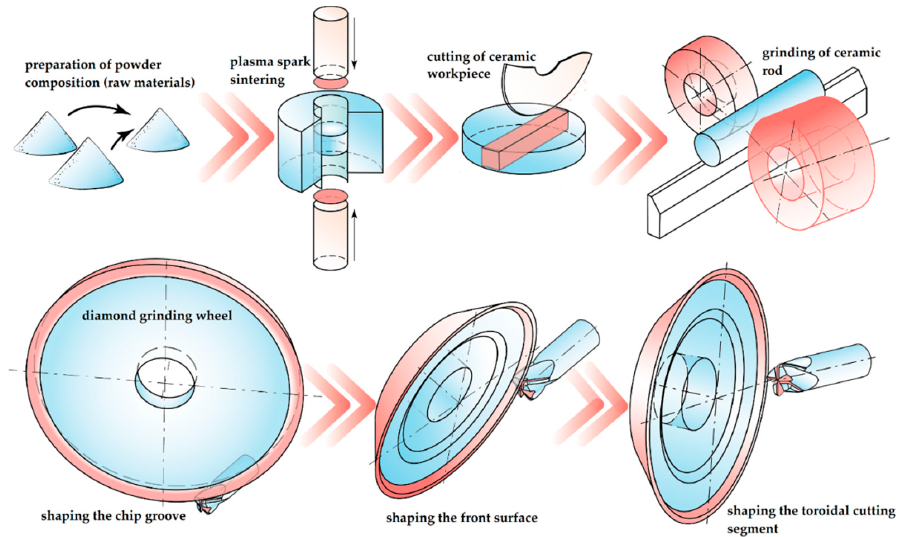
Figure 3. Technological algorithm for manufacturing solid ceramic end mills.